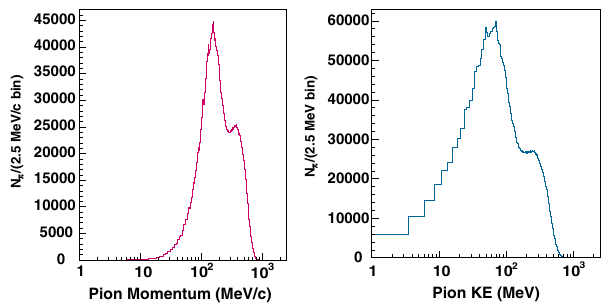
FIG. 6. Target thickness for 96% proton transmission through the muon target as a function of proton beam energy.